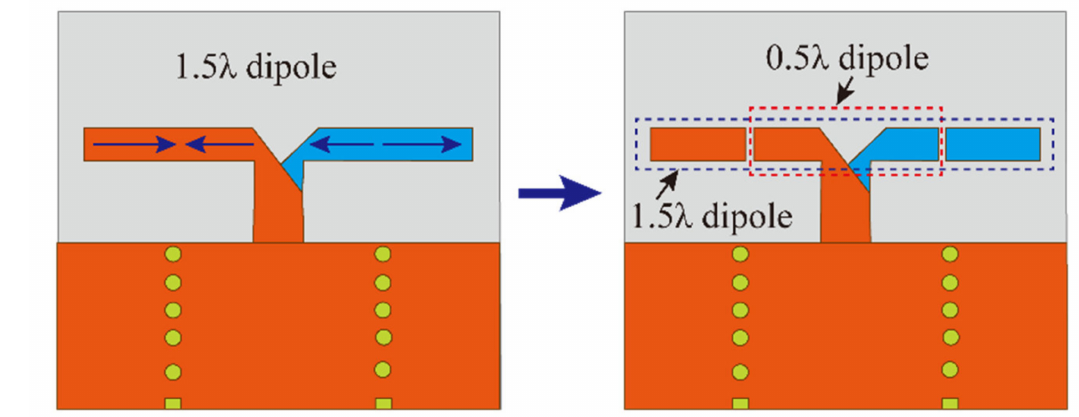
Figure 3. The evolution of wideband printed long dipole with dual resonant mode.